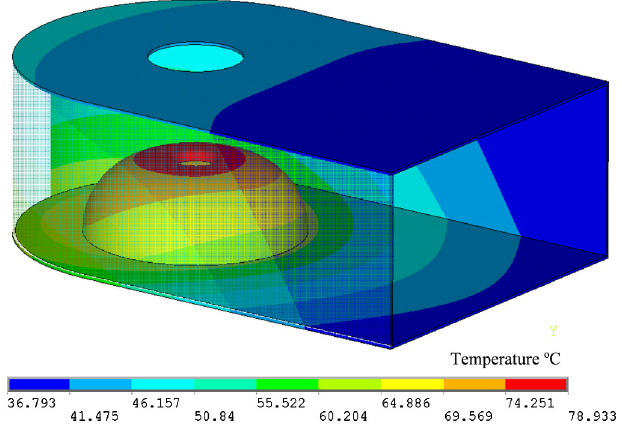
FIG. 8. Temperature contours for the 1 MW rf